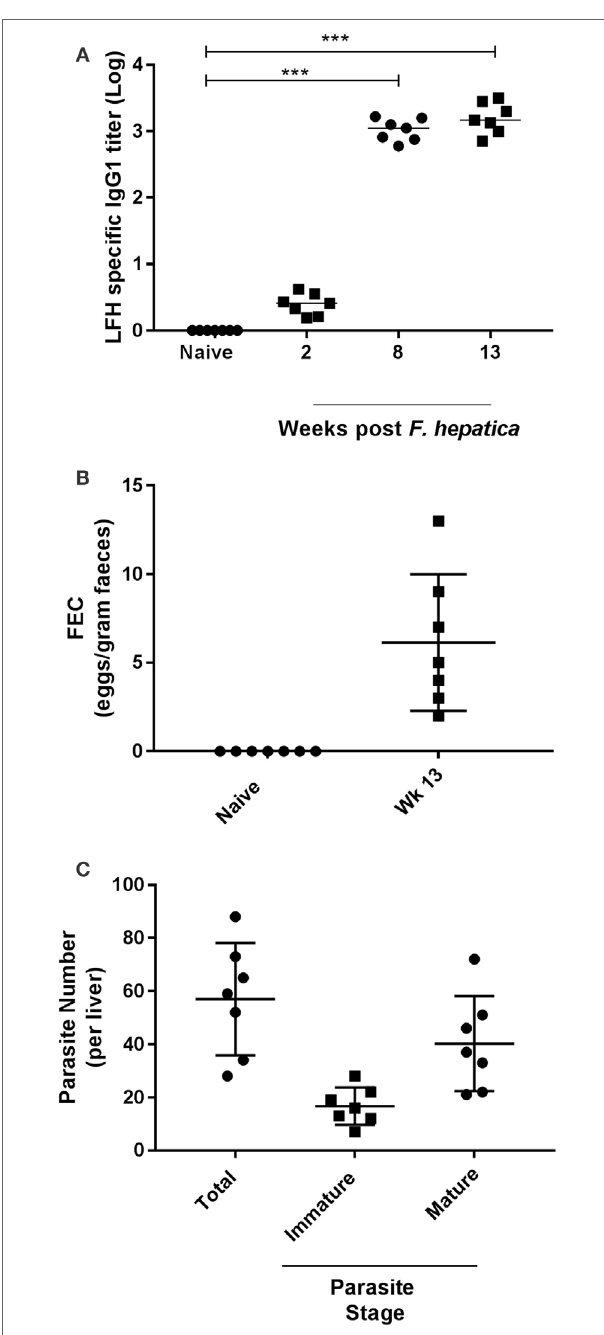
FigUre 1 | Parasitological parameters and seroconversion of infected animals. (a) Animals were examined for pre- and postinfection parasite-specific IgG1 antibody titers. Using a capture ELISA endpoint, log antibody titers were determined for each animal at the indicated time points. (B) Fecal egg counts (FEC) were performed using 1 g of feces from each animal before (naïve) and after infection at week 13. Data are presented as eggs per gram of feces. (c) At postmortem, livers were removed and examined from each animal. Total parasite numbers were determined for each liver. Additionally, parasites were classified as being immature or mature for each animal also. Each data point presented represents and individual animal with medias for each time point shown on the graph; data in (a) were examined for significance using a Kruskal–Wallis with Dunn’s multiple comparisons where *** P <